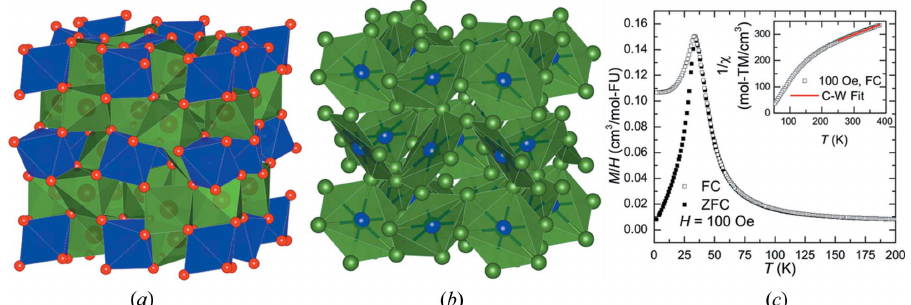
Figure 2 Structure and magnetization of bixbyite. ( a ) Polyhedral model of bixbyite, where the M 1 octahedra are shaded blue and the M 2 polyhedra are green. The red spheres are oxygen atoms each tetrahedrally coordinated by M . The octahedra share corners and edges to make a three-dimensional framework. ( b ) M -only atoms of bixbyite showing the near-neighbors of the M 1 sites (blue) surrounded by the M 2 sites (green). Nearly perfect hexagons of M 1( M 2) 6 result and share corners to make a three-dimensional cubic network. ( c ) Field-cooled (FC) and zero-field- cooled (ZFC) magnetization data for bixbyite. The inset shows the 1/ (cid:8) behavior, the red line indicating the Curie–Weiss fit.